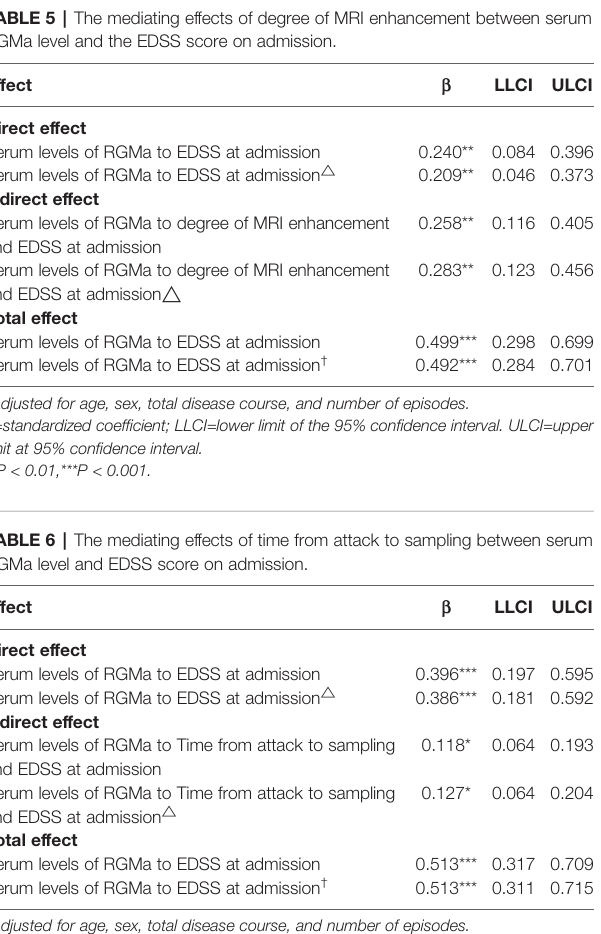
FIGURE 4 | Correlation between serum RGMa level and Delta EDSS score in NMOSD after adjusting for sex, age, total disease course, time from attack to sampling, and number of episodes.